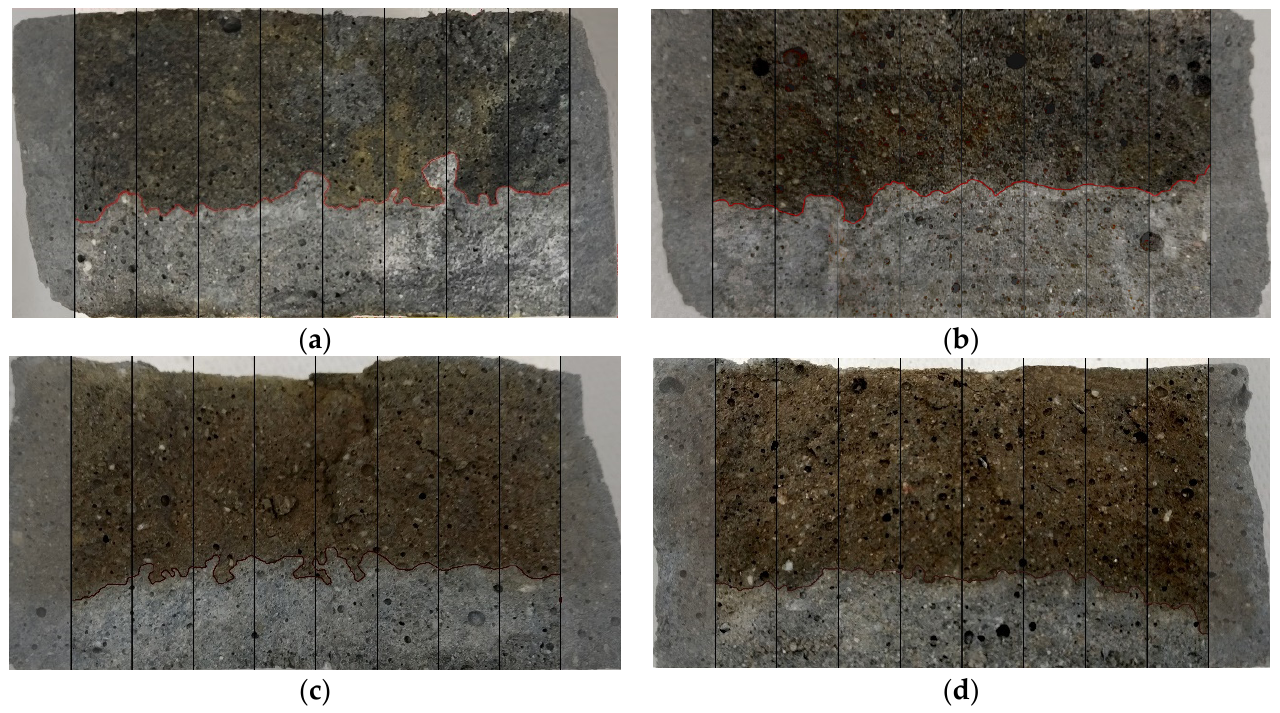
Figure 8. Specimens split for chloride penetration depth measurement after 18 h at 2.50 V: ( a ) AAM0 x d = 21.20 mm; ( b )